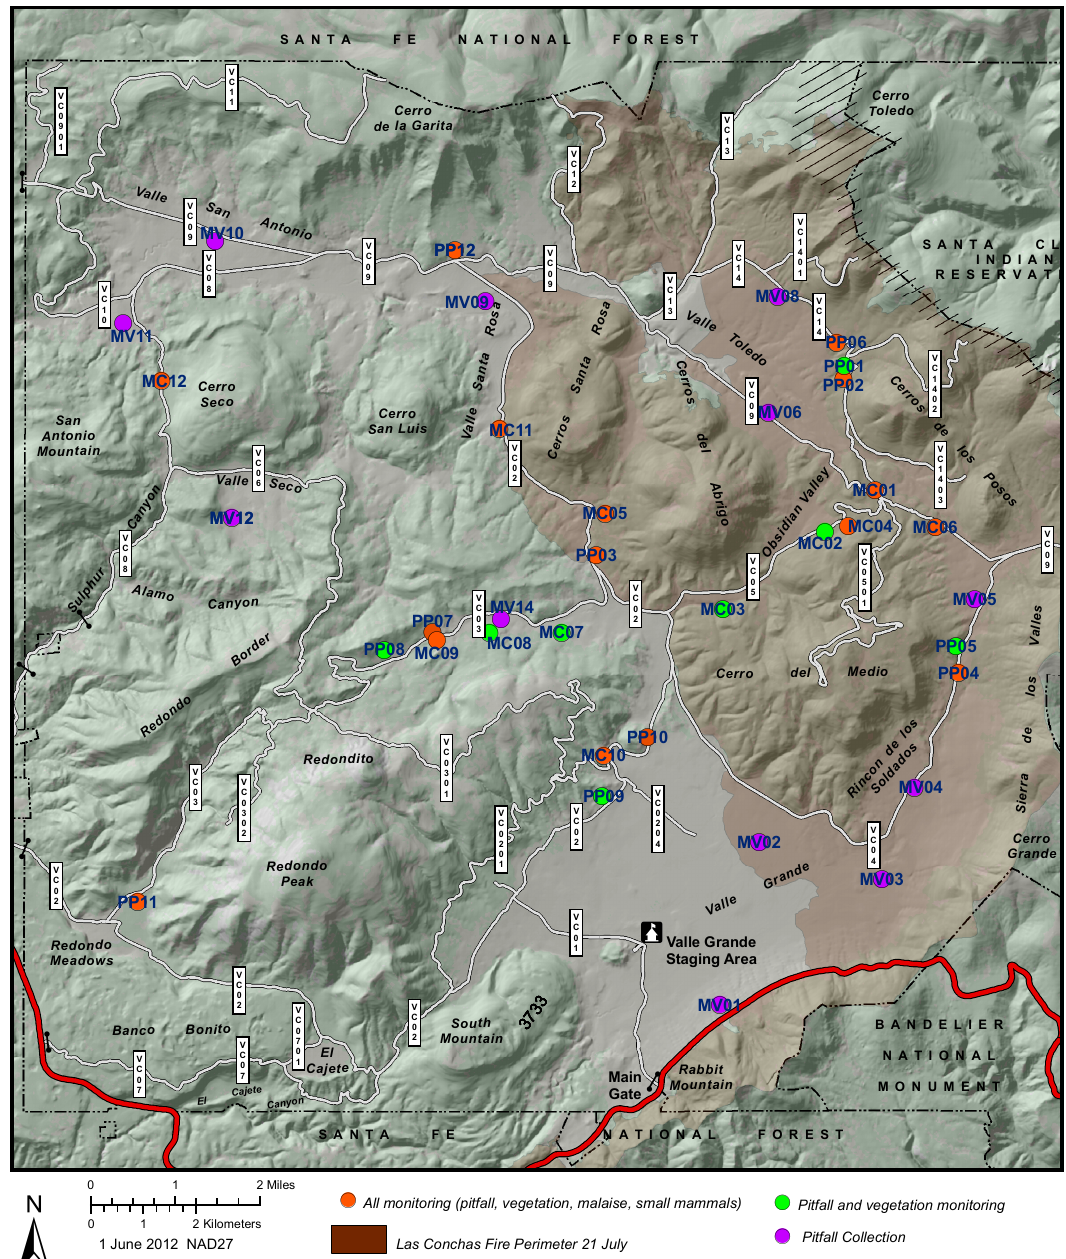
Figure 3. Map of the extent of the Las Conchas wildfire study sites for arthropod pitfall traps at the Valles Caldera National Preserve, and the location of pitfall trap sites. Burned areas are to the right; unburned areas are to the left on the